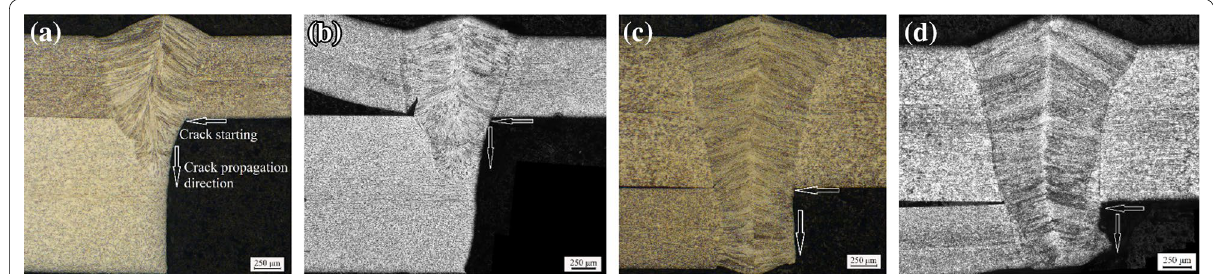
1.5-N failed at 1.01 +